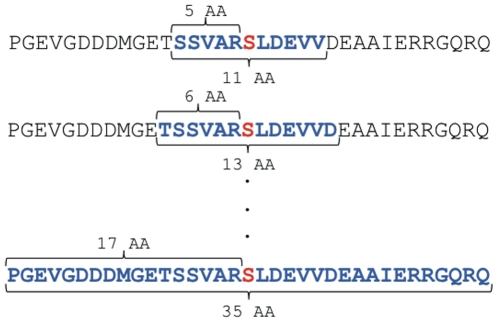
Sequence windows used to extract phosphorylation motifs.The sequence represents an example of the phosphorylated region of a protein, showing the backbone structure of the different window sizes used to extract phosphorylation motifs. The red letter represents the phosphorylated residue (always centered), the blue letters were emphasized to show the surrounding amino acids included in each of the window sizes.